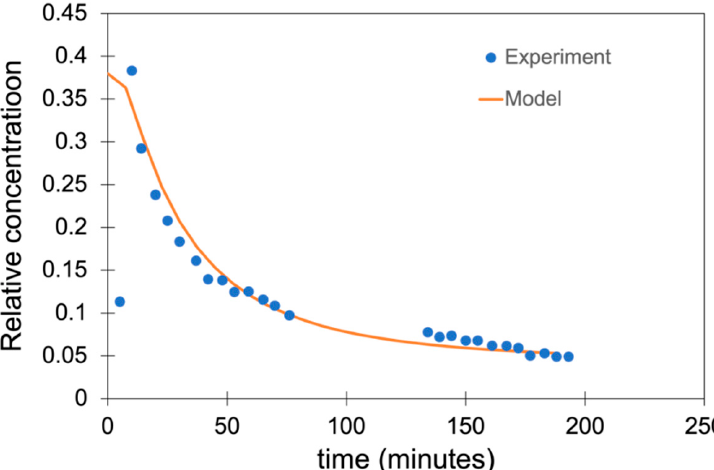
Figure 6. Desorption breakthrough curve of tetracycline with 1 M magnesium nitrate in a geofilter prepared with stevensite pellets treated at 200 °C, previously saturated with 1 g/L TC. Blue dots indicate the experimental data and the orange line the model fitting with STANMOD.